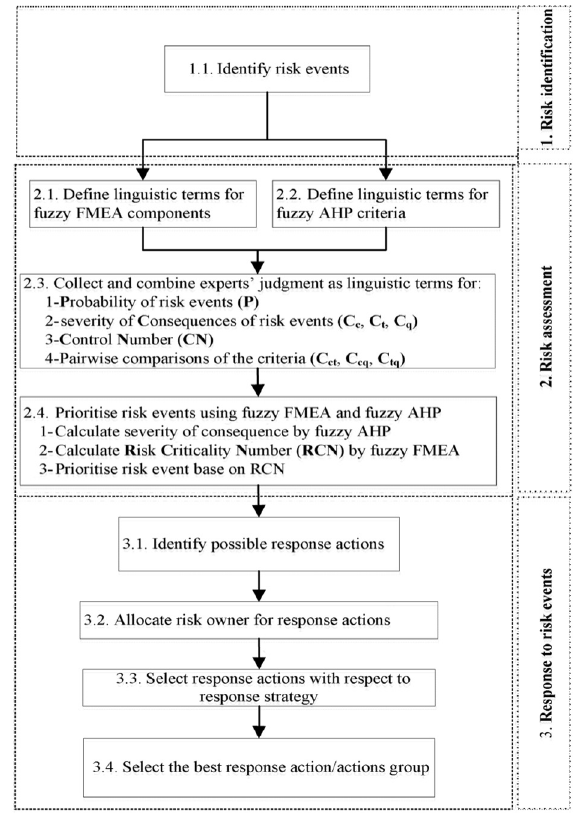
Fig. 1. Proposed framework of risk management